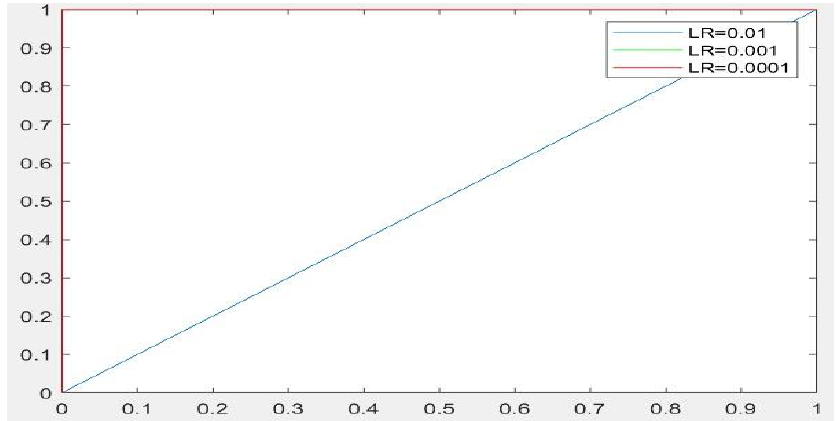
Figure 12. ROC curves showing the performance of AlexNet on testing data sets with the three learning rates of 0.01, 0.001, and 0.0001.